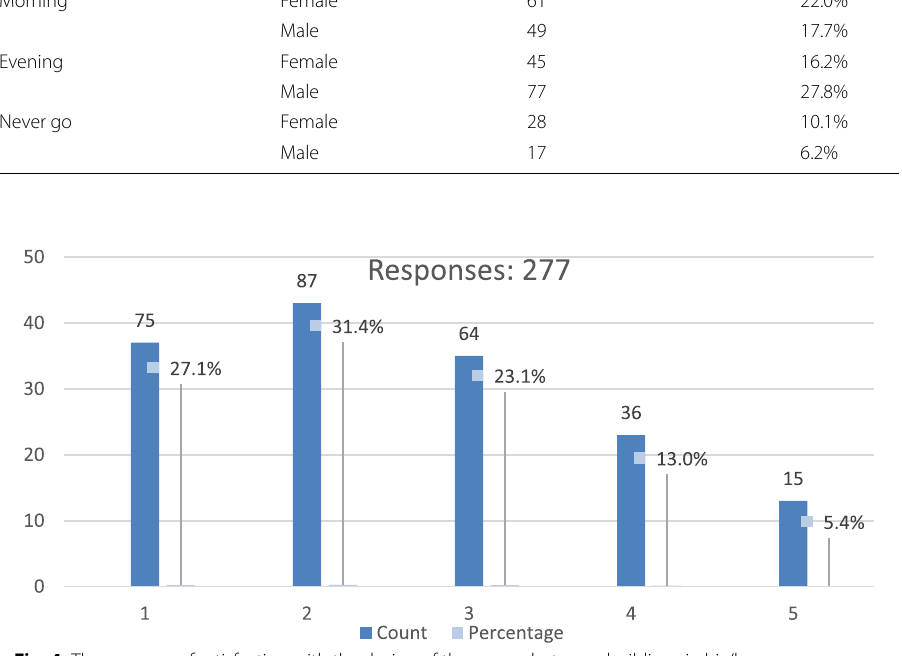
Fig. 4 The measure of satisfaction with the design of the spaces between buildings in his/her